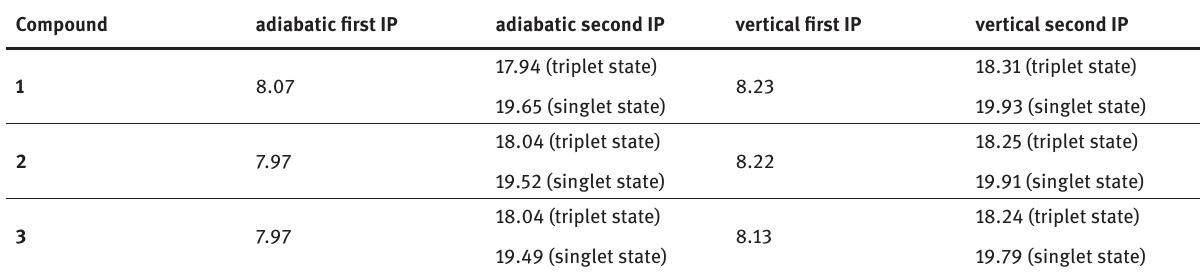
Compound adiabatic first